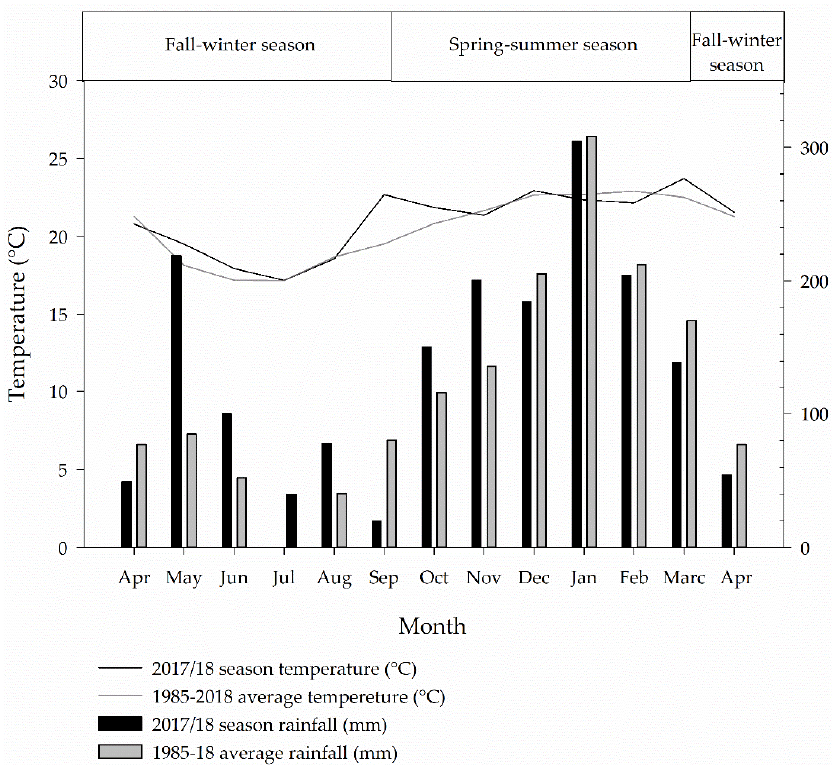
Figure 2. Means of monthly temperature and rainfall between the years 1985 and 2018 and during the 2017/18 season.